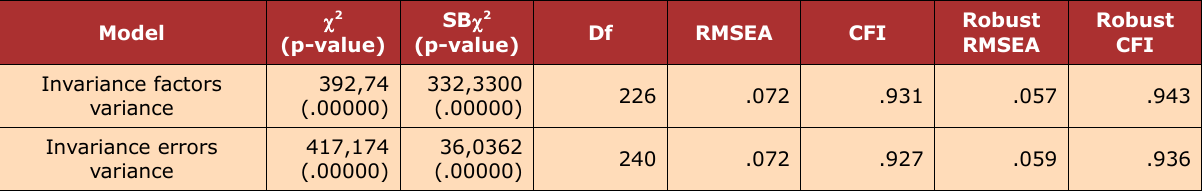
Table 10. Goodness of fit indexes for latent factors variance invariance